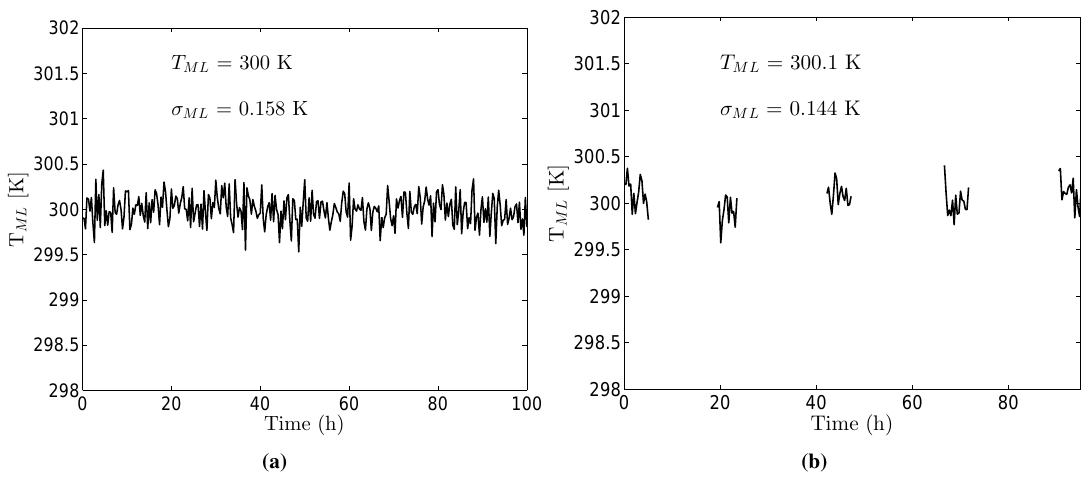
Figure 3. Simulated (a) and measured (b) radiometer brightness temperatures and the corresponding resolutions. The scene is a temperature stabilized matched load. The brightness temperature and the resolution is solved for entire 97 h in the simulation. In the measurement it is solved during the five cryogenic load cool-downs, each lasting about five